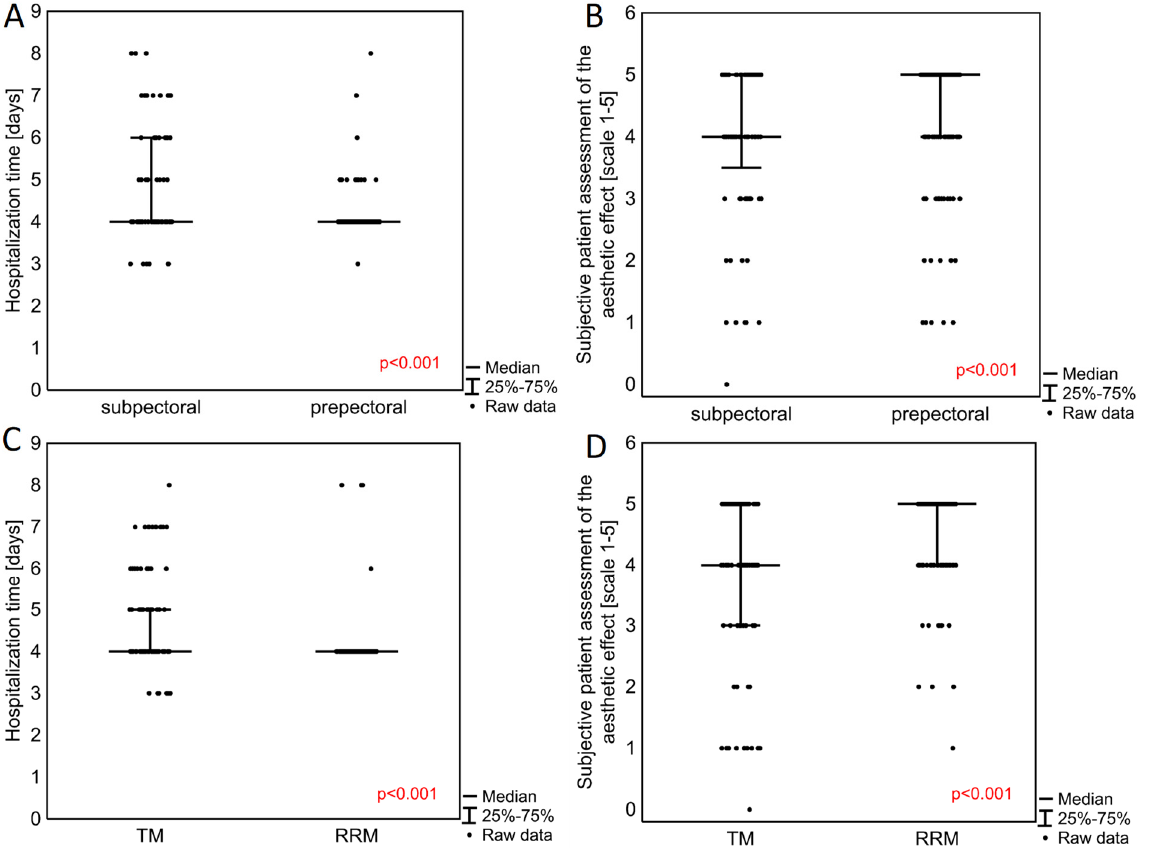
Figure 2. Hospitalization time ( A ) and subjective patient assessment of the aesthetic effect of surgery ( B ) in patients undergoing subpectoral vs. prepectoral breast reconstruction technique and in patients undergoing therapeutic (TM) or risk-reducing mastectomy (RRM) ( C , D ). p -values obtained with Mann–Whitney U test. Box plots comparing the duration of hospitalization after the procedure, in days, and the subjective patient assessment of the final effect (patient-reported aesthetic outcome) on a scale from 1 to 5, according to subpectoral vs. prepectoral breast reconstructions ( A , C ), and also type of surgery, i.e., TM vs. RRM ( B , D ).